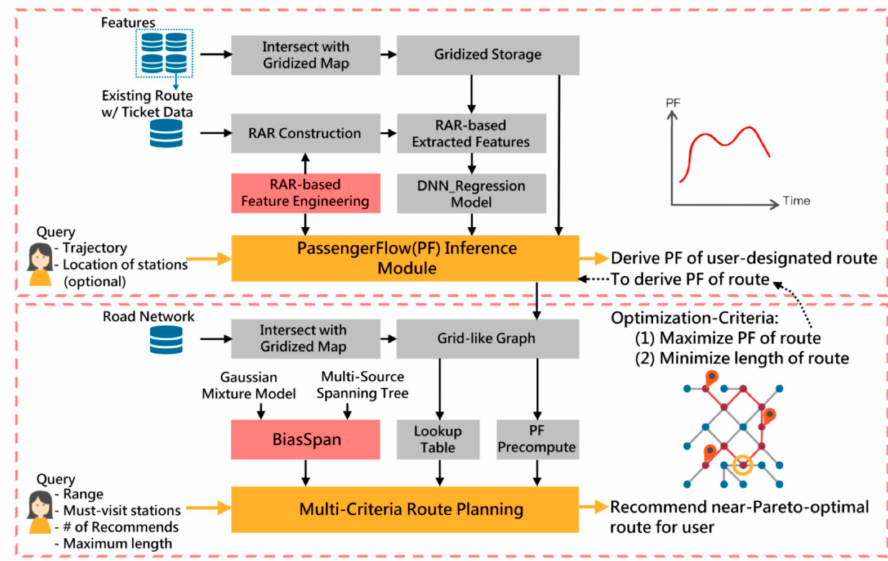
Figure 1. System flow for solving the nonmonotonic multicriteria constrained route